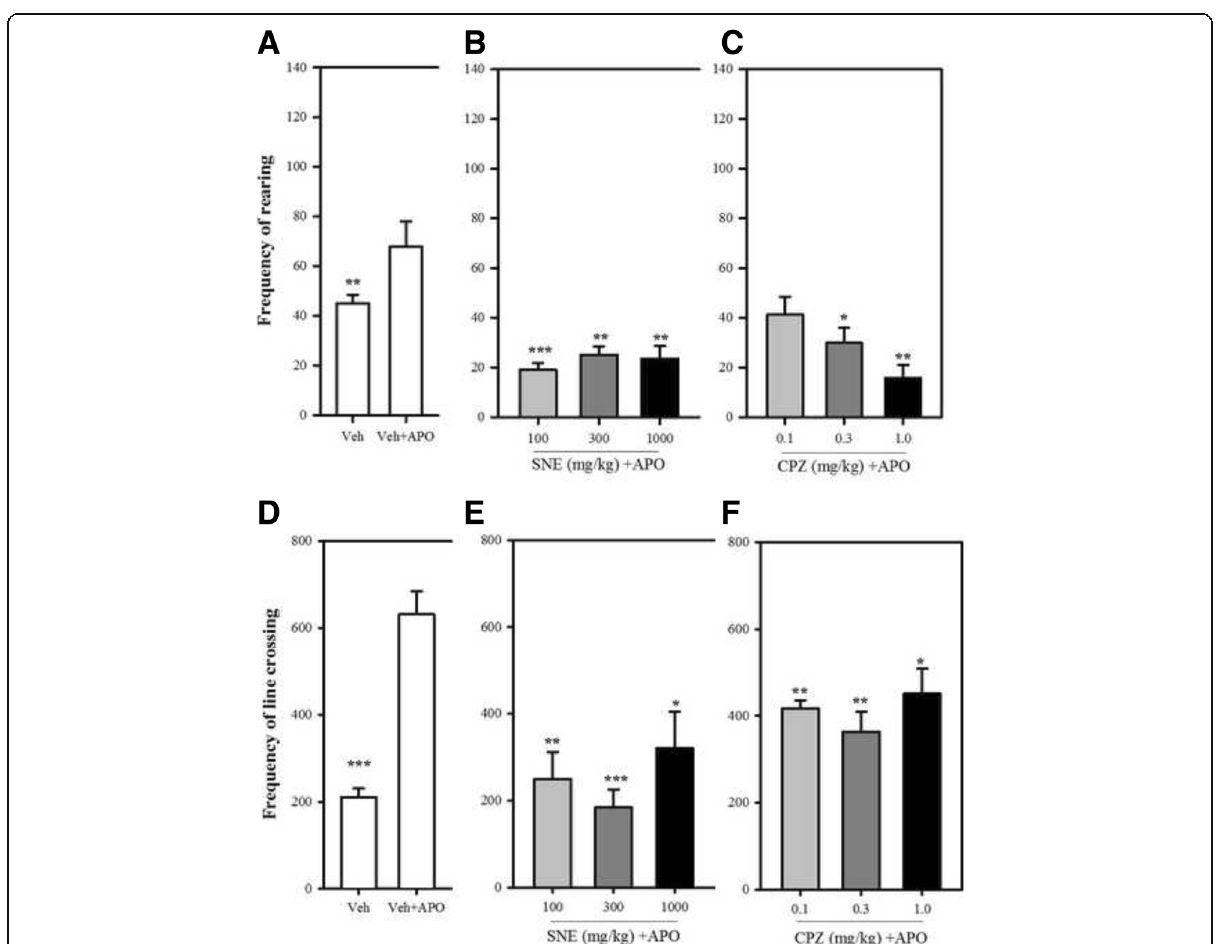
Fig. 3 Effect of SNE, CPZ and vehicle (Veh) (distilled water, 0.01 ml/kg, p.o) on the frequency of rearing ( A, B and C ) and line-crossings ( D, E and F ) of mice, 30 min post apomorphine (APO) (2 mg/kg, i.p) treatment in an open-field paradigm. Data are mean ± SEM ( n = 5). * P ≤ 0.05, ** P ≤ 0.01, *** P ≤ 0.001 compared with Veh + APO group (one-way ANOVA followed by a Dunnett ’ s multiple comparison post hoc